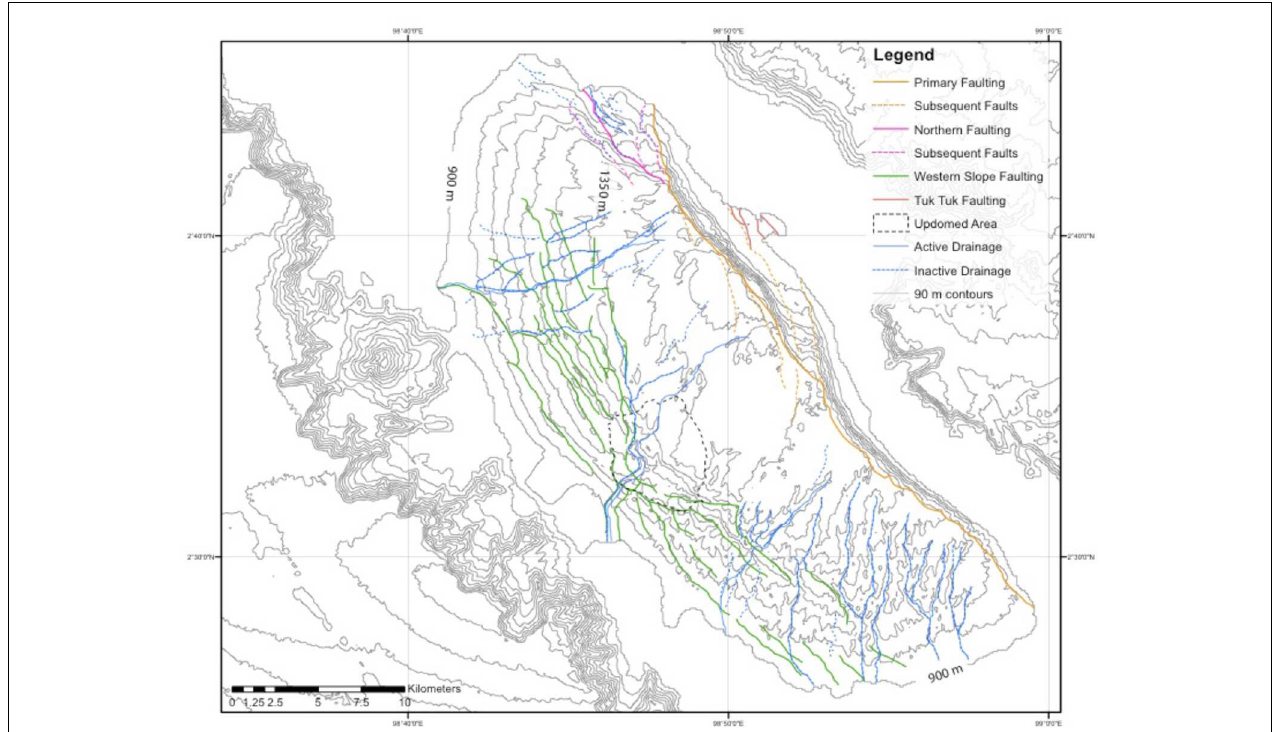
FIGURE 5 | Map of faulting and drainage evolution on Samosir. Stage 1: The main uplift was accommodated by normal faulting stepping down to the east—the Samosir Fault system (Orange). During and subsequent to this primary faulting event, hinge faults formed, branching off the primary fault. Hinge faults on the hanging wall branched up to the north, whereas the faults on the footwall thrown side branched down to the south. Stage II: Subsequent faulting on the north of Samosir (Magenta). Normal faulting along an extension of the primary fault caused blocks to slump along hinge faults, cutting across the established primary drainage system. The drainage system was offset and captured by these hinge faults, creating a secondary drainage system that is currently in place. Stage III: A third stage of faulting (Green) occurred sometime after these initial two stages. This